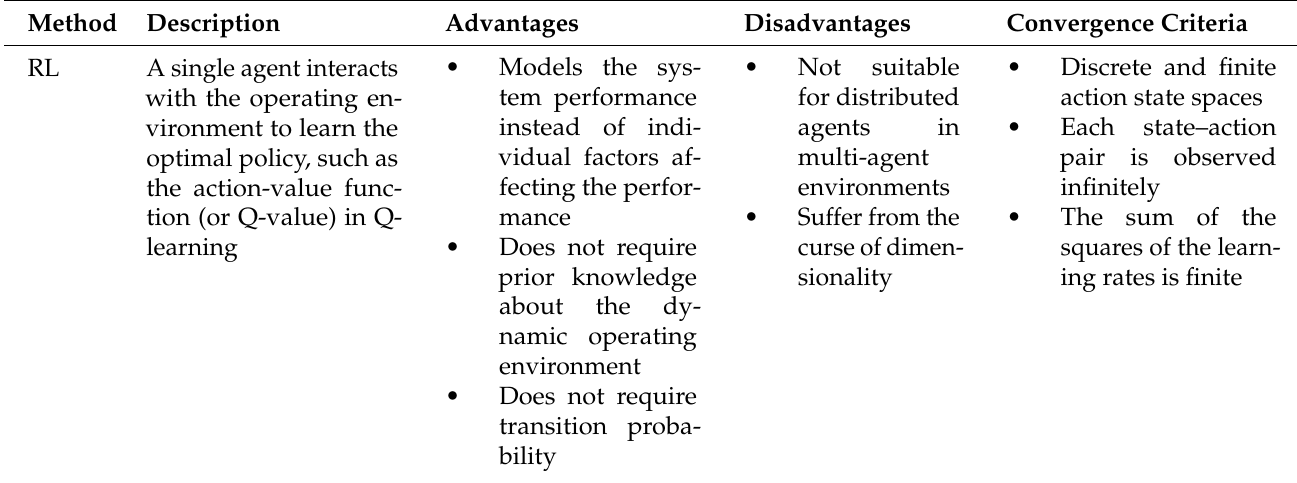
Table 2. A summary of comparisons between MADQN and other preceding approaches. Method Description Advantages Disadvantages Convergence